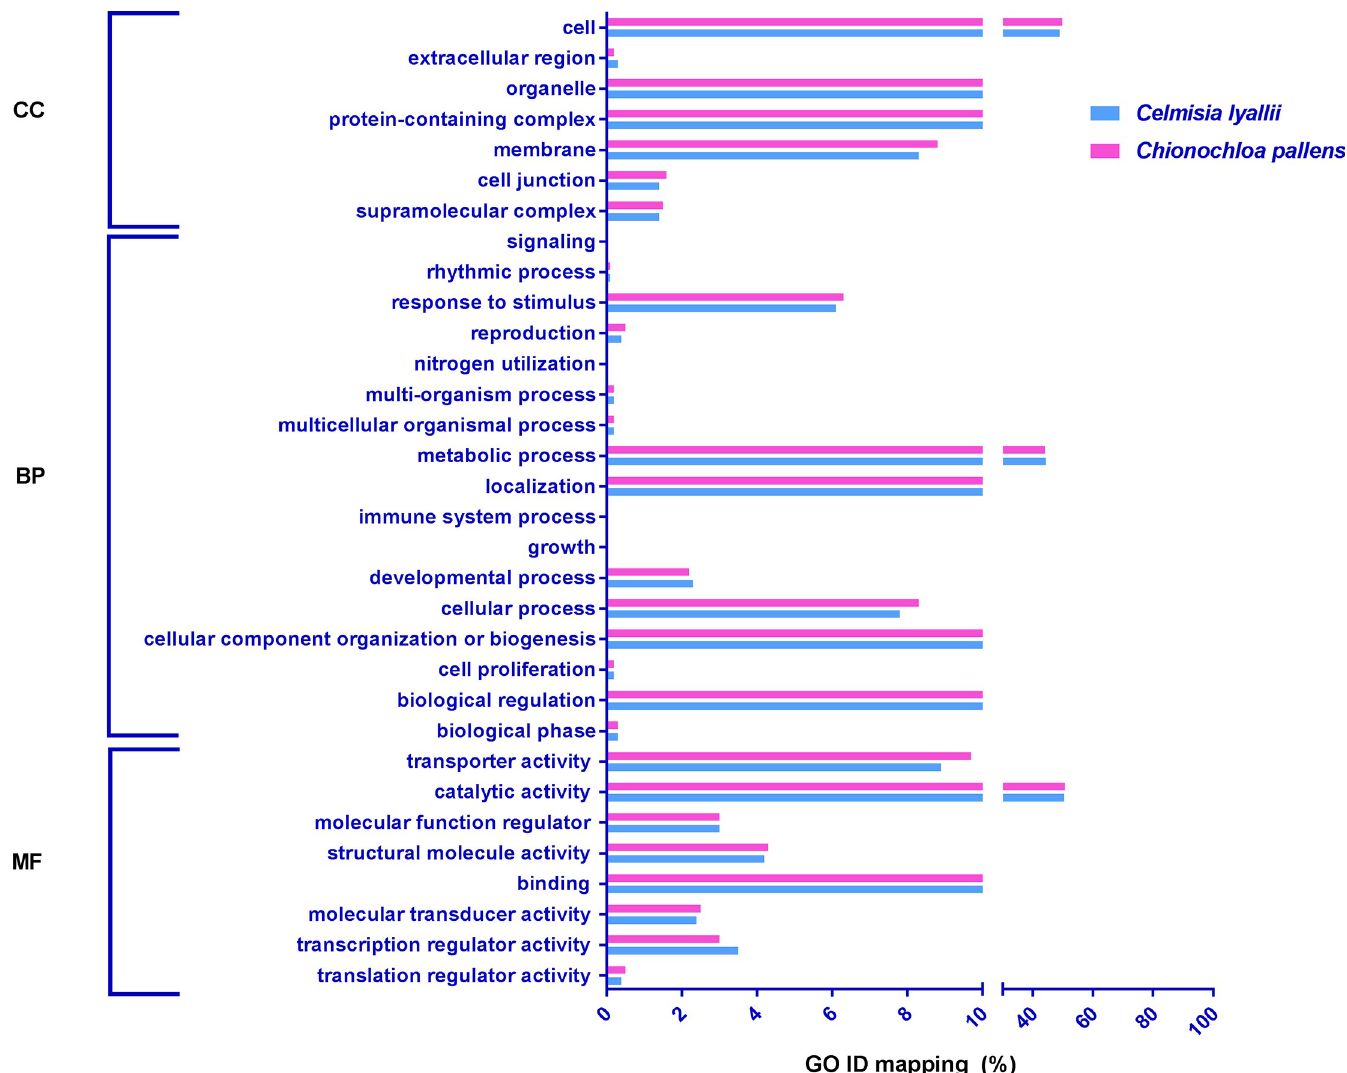
Fig 1. GO analysis of the assembled transcriptomes of C . lyallii and C . pallens . Transcripts were categorised into 32 different GO categories sub-divided into molecular function, biological process, and cellular